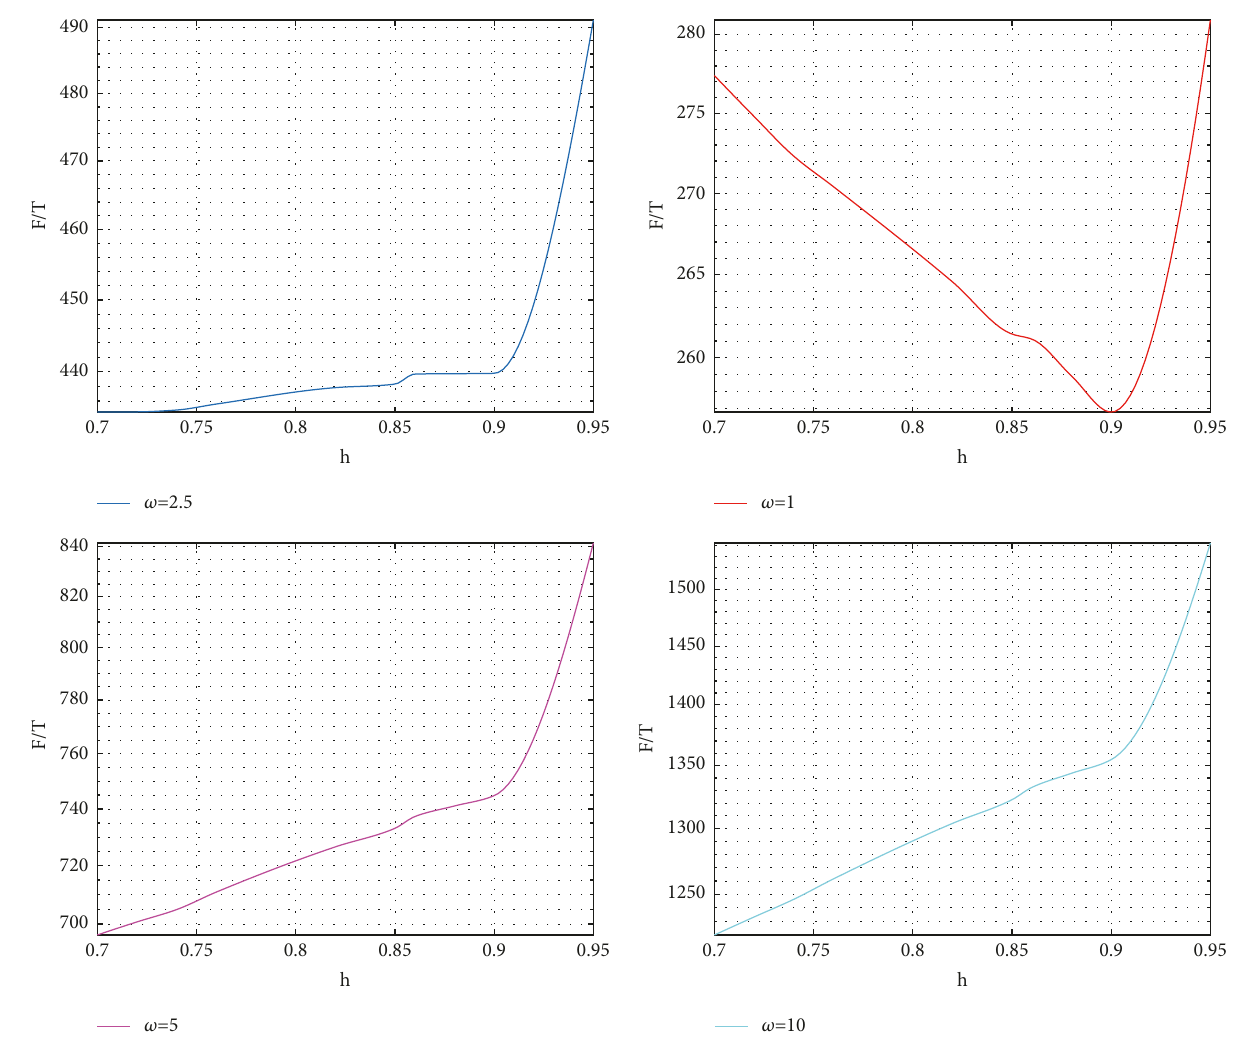
Figure 10: The change in the cost per unit time 𝐹/𝑇 on the control level ℎ for 𝜄 2 /𝜄 1 = 2.5, 1,5,10